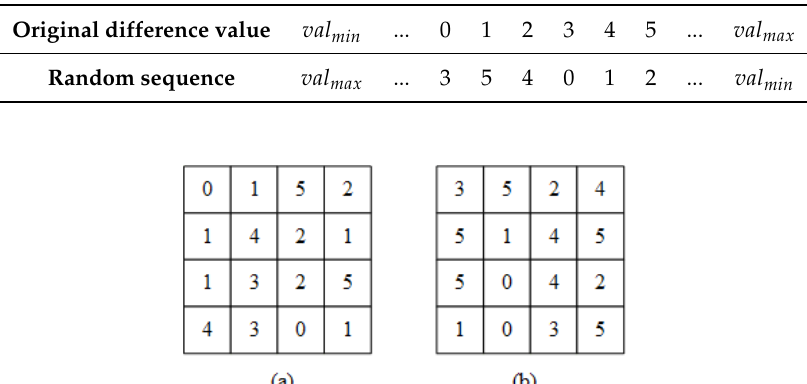
Table 1. The sequence example.